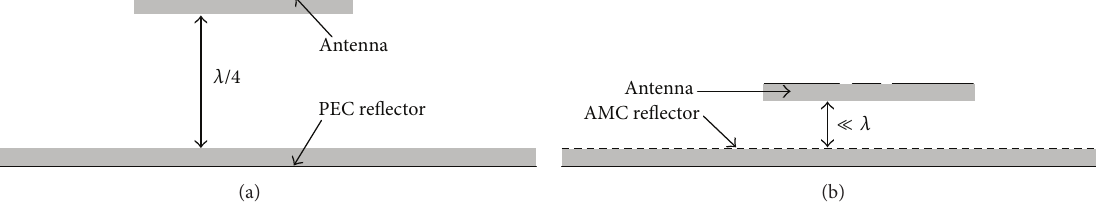
Figure 1: Illustration of the theory for antenna with (a) PEC reflector, (b) AMC reflector.